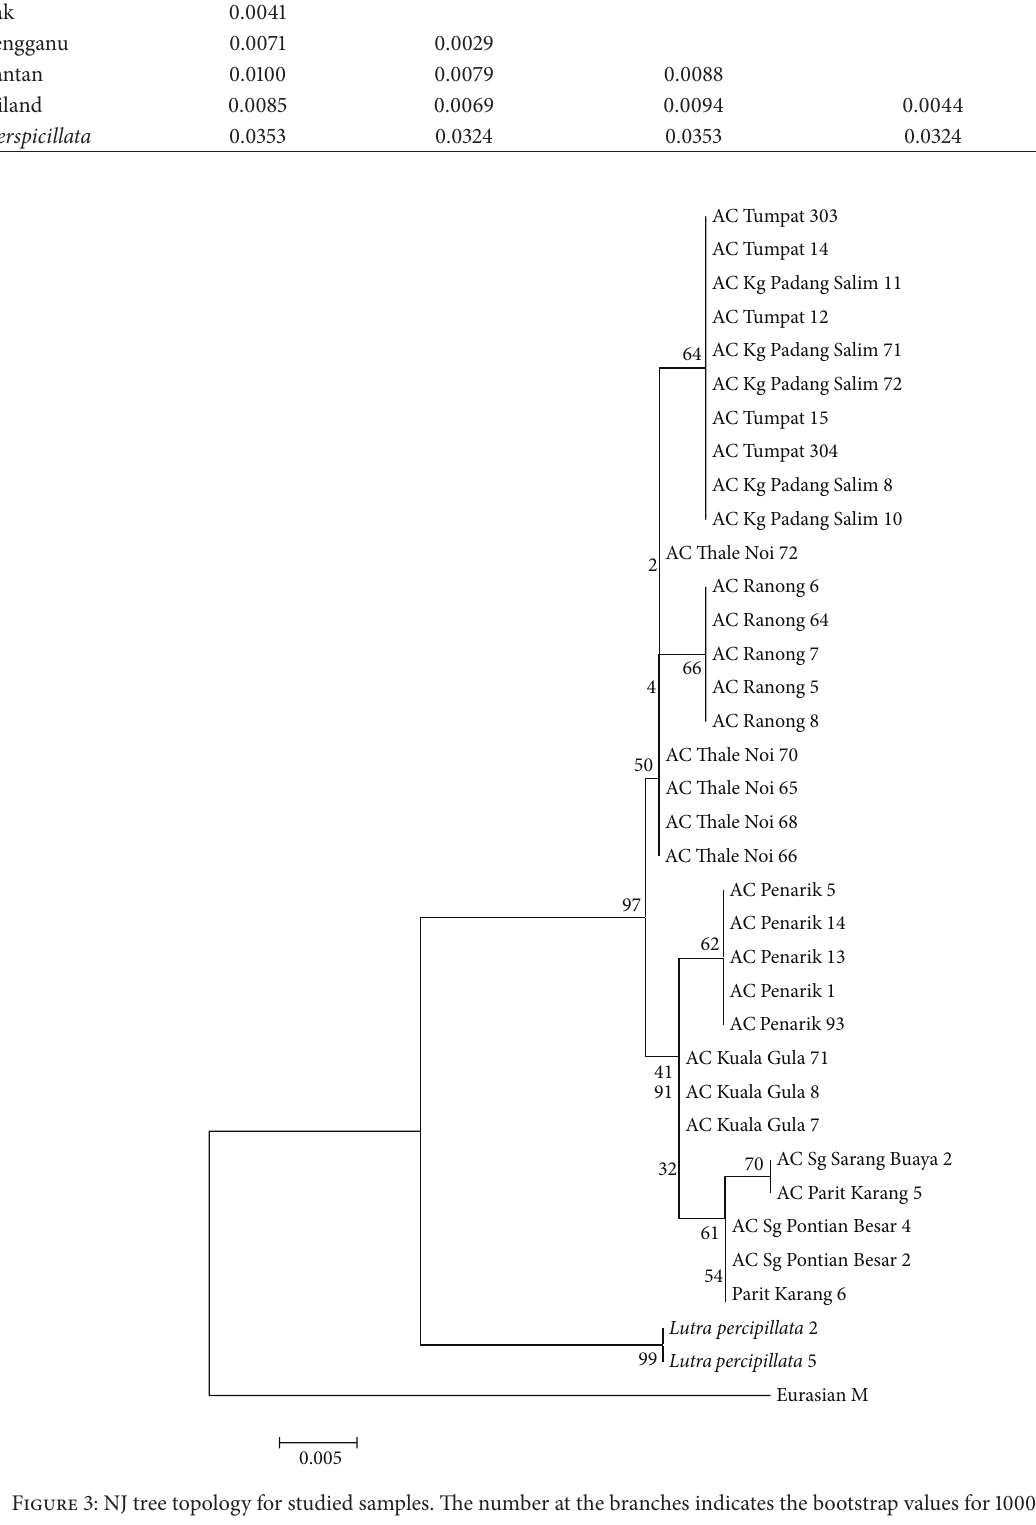
Figure 3: NJ tree topology for studied samples. The number at the branches indicates the bootstrap values for 1000